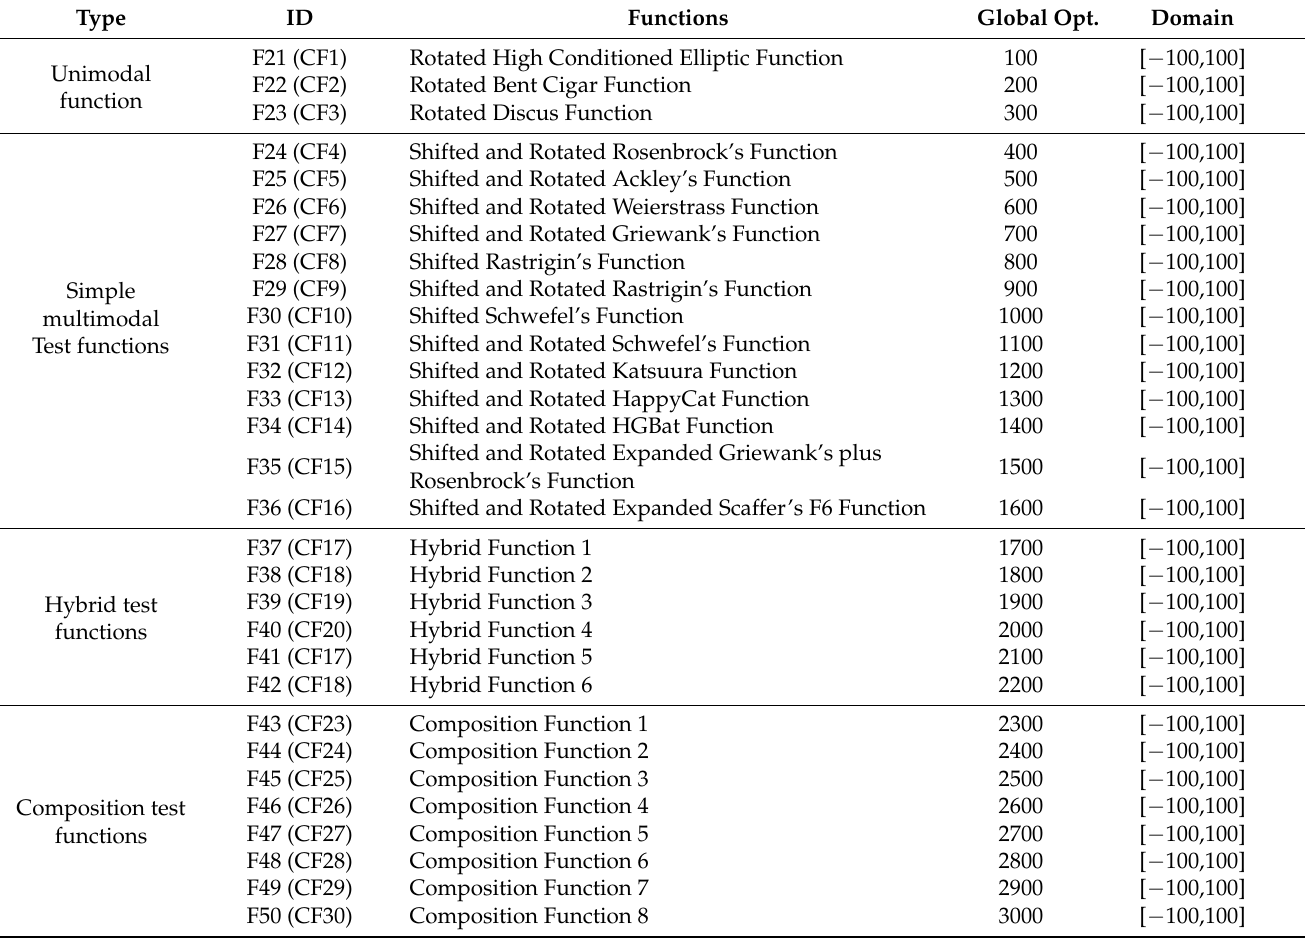
Table A4. Description of CEC-2014